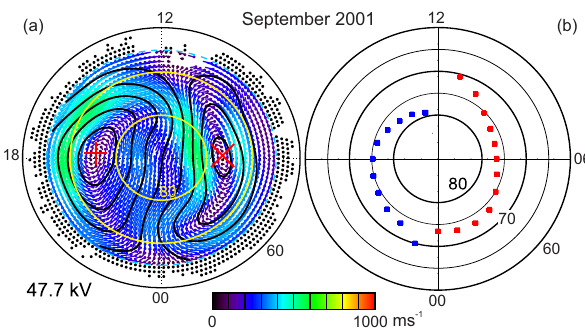
Figure 2. (a) Convection pattern in the MLT-MLAT coordinates inferred from the September 2001 SuperDARN grid velocity data set ( B − t = [ − 4,0]nT) by applying the SCHA technique of Fiori et al. (2010). Every dot represents the origin of a plasma velocity vector with the length coded by color. Overlaid are contours of the equal electric potential (that are 6kV apart). Potential difference be- tween the foci of the large-scale convection cells is 47.7kV. (b) The convection reversal boundary location inferred from the data pre- sented in panel (a) for dusk (blue dots) and dawn (red